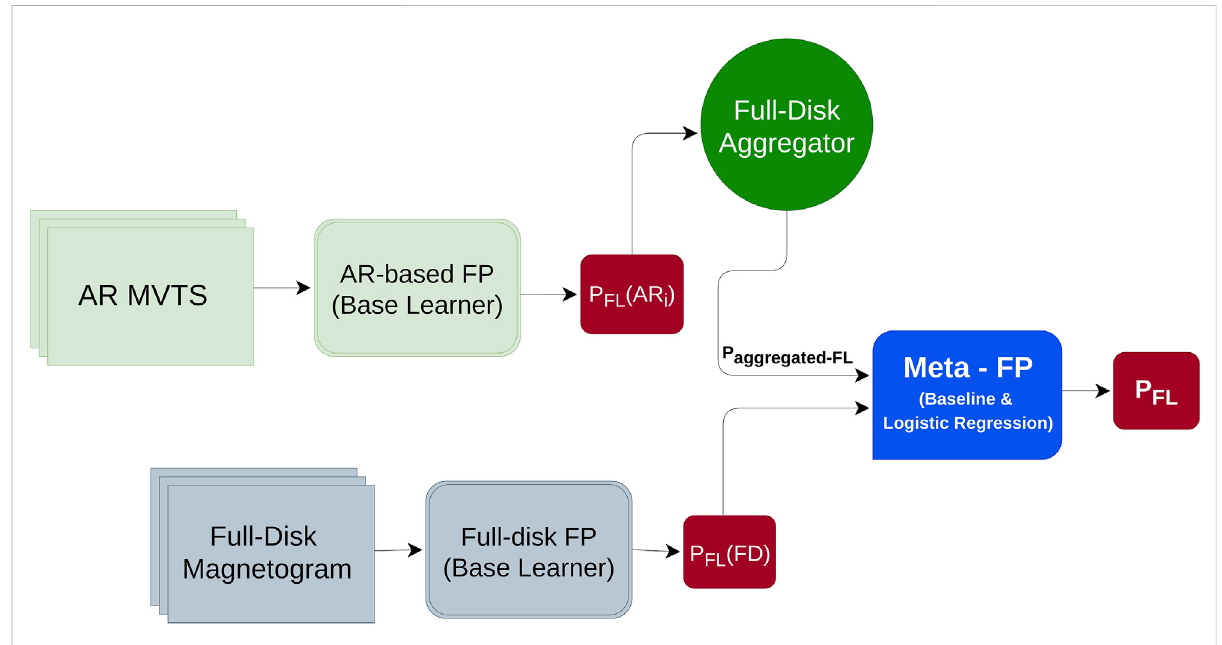
FIGURE 3 Anillustrationofourensemble fl arepredictionpipelineshowingtwobaselearners(AR-basedFP)and(Full-diskFP)andtheensemble(Meta-FP) followed by full-disk aggregation of AR-based FP ’ s fl are